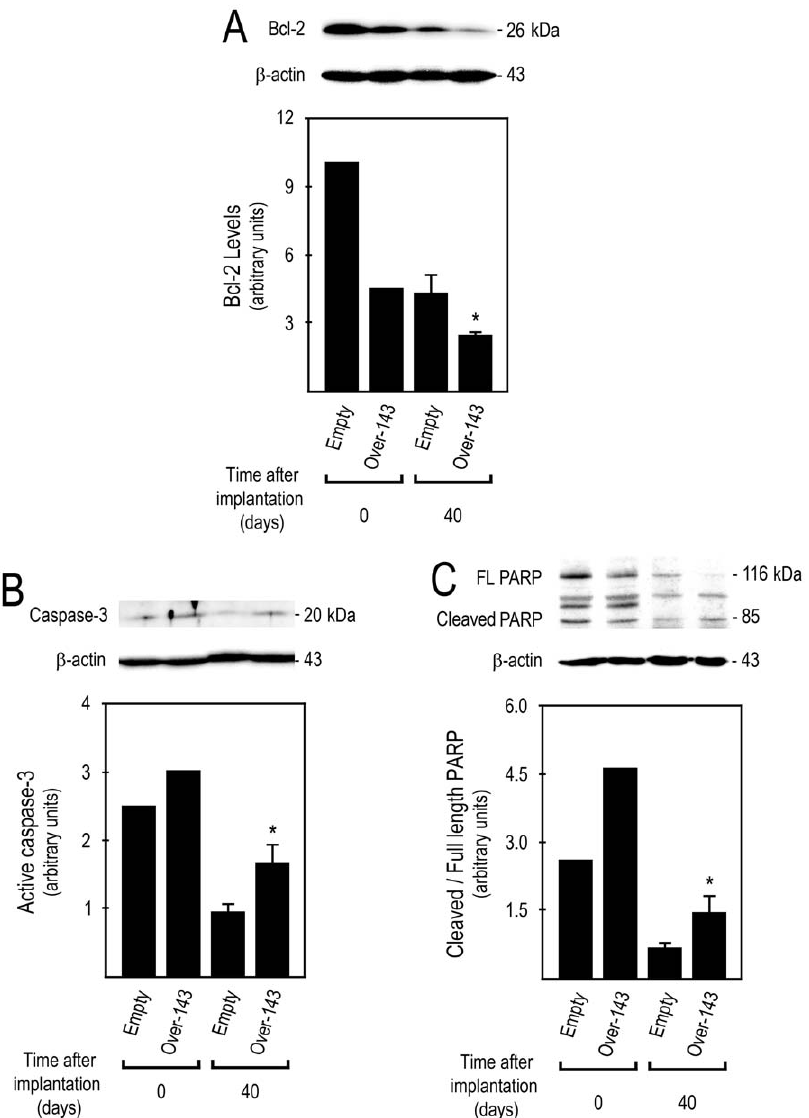
Figure. 5. miR-143 overexpression reduces Bcl-2, and increases caspase-3 processing and PARP cleavage in tumor xenografts. Total proteins were extracted from Over-143 and Empty cells prior to implantation into animals (t=0 days) and from snap frozen tumor xenograft samples (t=40 days), and used to determine by Western blot: A, steady state levels of Bcl-2; B, active caspase-3; and C, PARP cleavage. Results are expressed as mean 6 SEM. FL, full length. * p , 0.05 from Empty